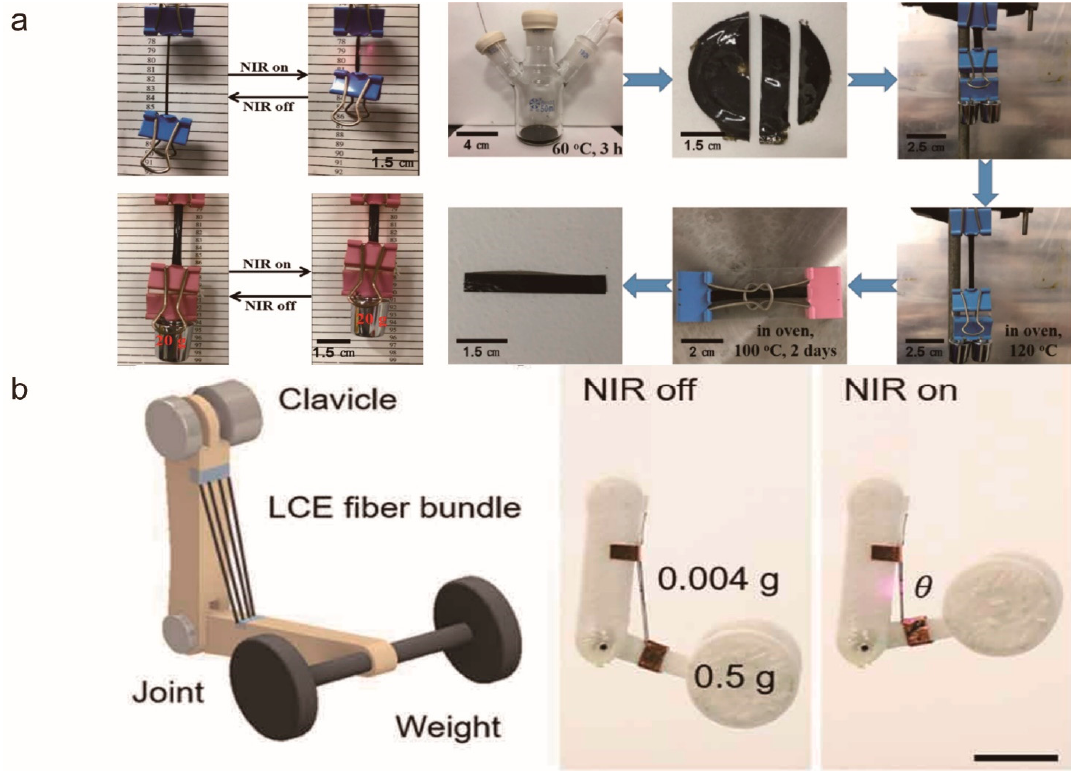
Figure 15. ( a ) Images of an LCE film lifting up a binder clip and load under NIR light illumination (left) and the preparation process of the film (right) (Reprinted with permission from Ref. [107]. Copyright 2017, American Chemical Society). ( b ) Schematic and image of an LCE fiber arm lifting a heavy object (Reprinted with permission from Ref. [110]. Copyright 2021, the American Association for the Advancement of Science).